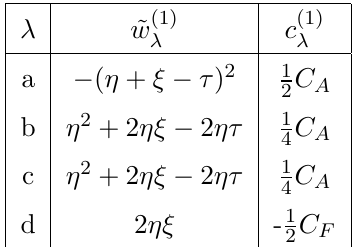
Table 3 . The weights ~ w (1)